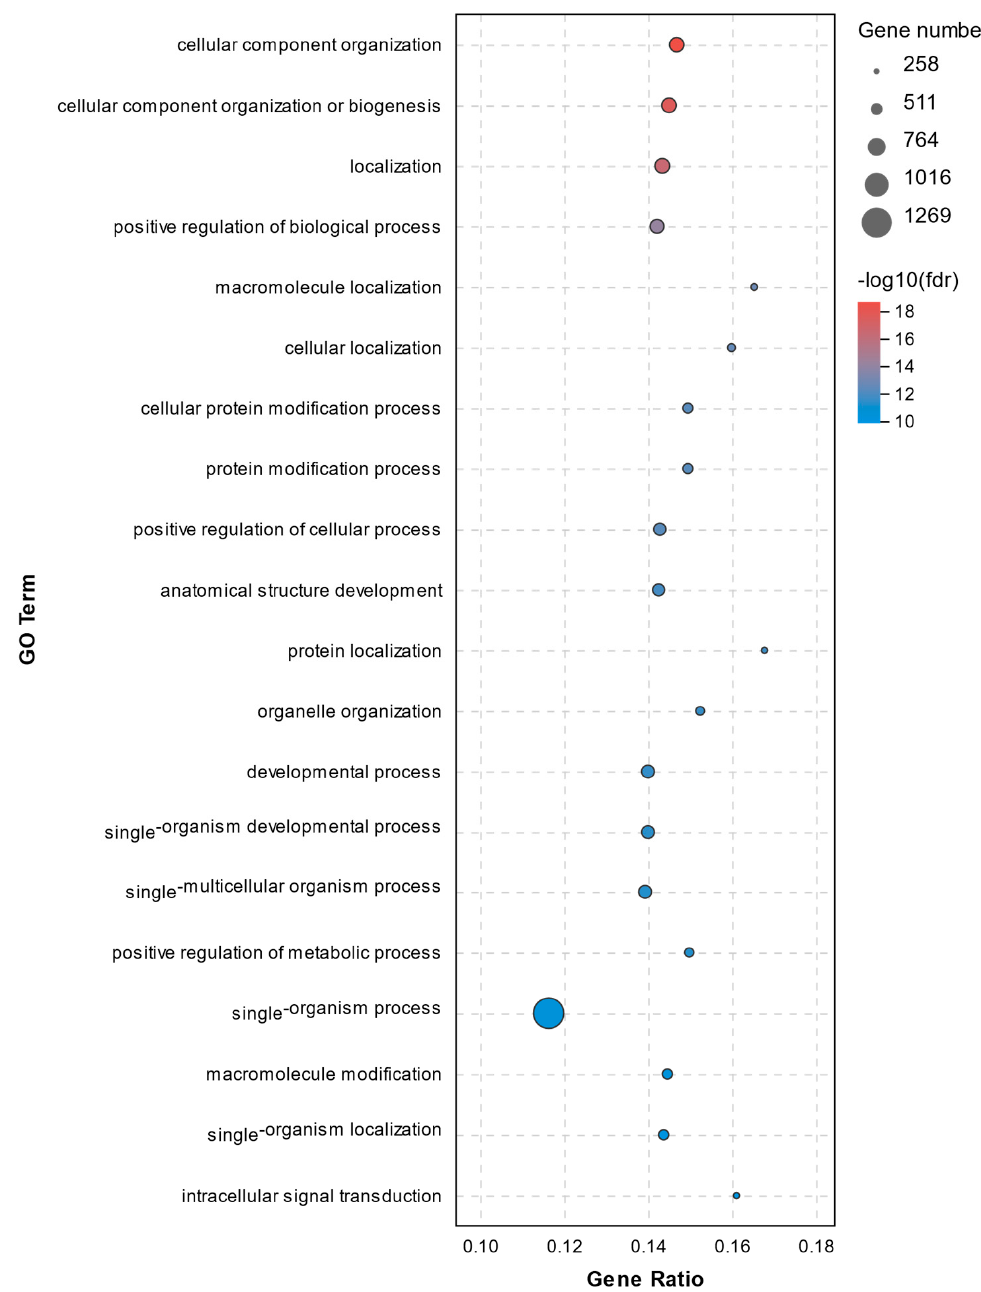
Figure 6. Top20 GO terms for DEGs between the C1 and T1 groups.